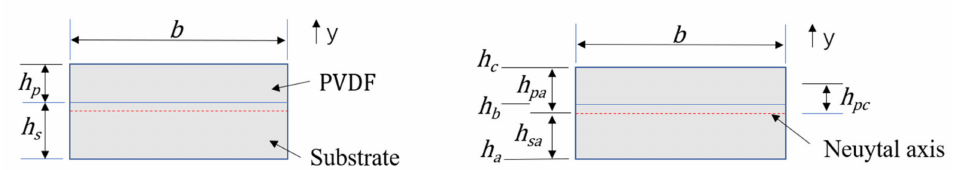
Figure 3. Geometric dimensions of the flexible beam